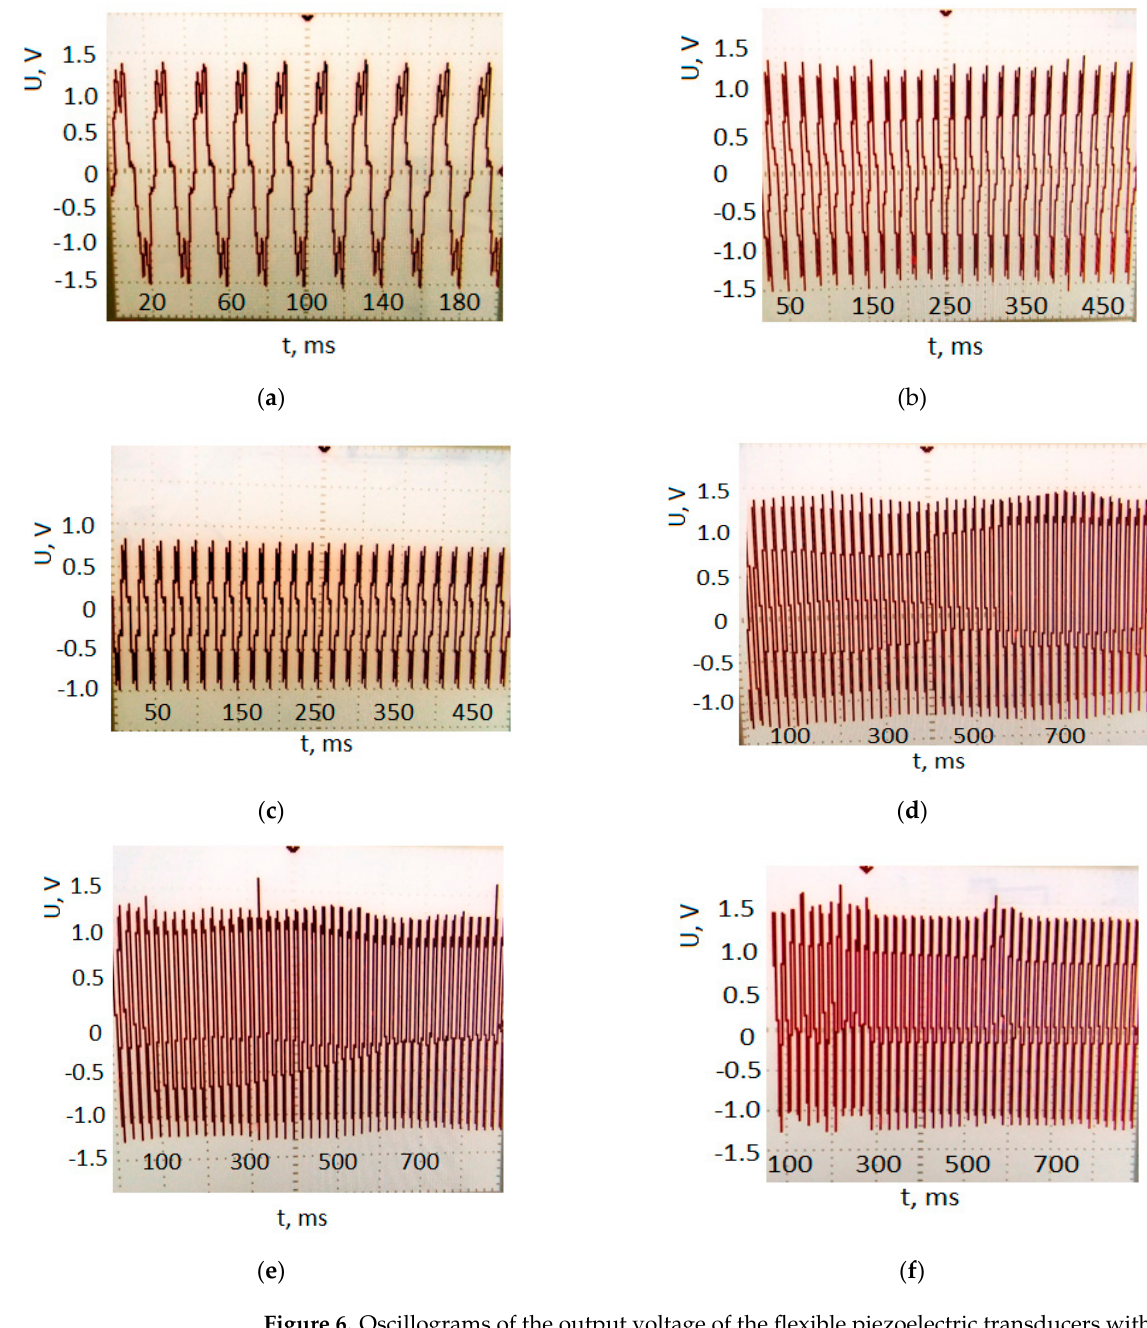
Figure 6. Oscillograms of the output voltage of the flexible piezoelectric transducers with BST only and hybrid BST+PVDF-TrFE films at different duration of bending: BST at switching ( a ); BST after 1 h of bending ( b ); BST after 2 h of bending ( c ); hybrid BST+PVDF-TrFE at switching ( d ); hybrid BST+PVDF-TrFE after 1 h of bending ( e ); hybrid BST+PVDF-TrFE after 2 h of bending ( f ). Table 2. Summarized values of the open circuit RMS voltage, short circuit current, and power produced at different durations of bending applied onto the BST and hybrid BST+PVDF-TrFE sample. At Switching After 1 h Parameter